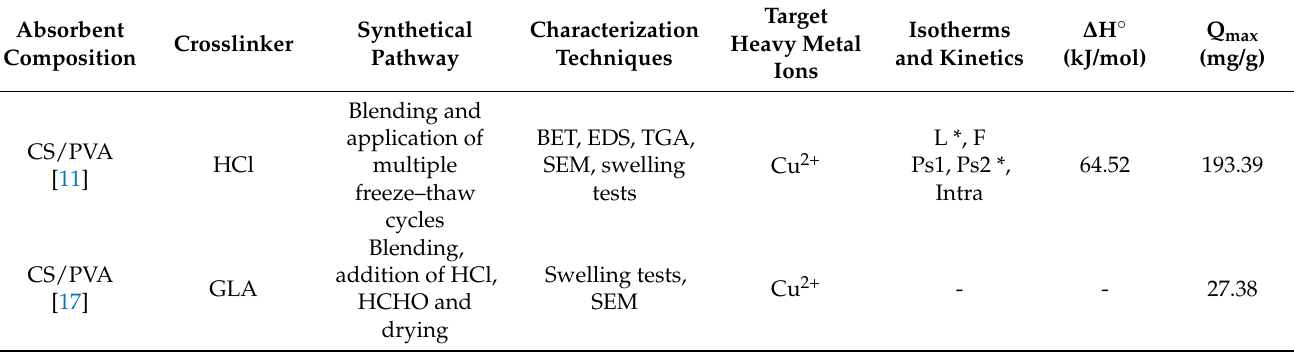
Figure 10. SEM micrographs of PVA/CS foam with different magnification: ( A ) 30 × , ( B ) 50 × , ( C ) 400 × and ( D ) 10,000 × . Reprinted from [11]. Table 4. CS/PVA-based foams adsorbents for heavy metal ions